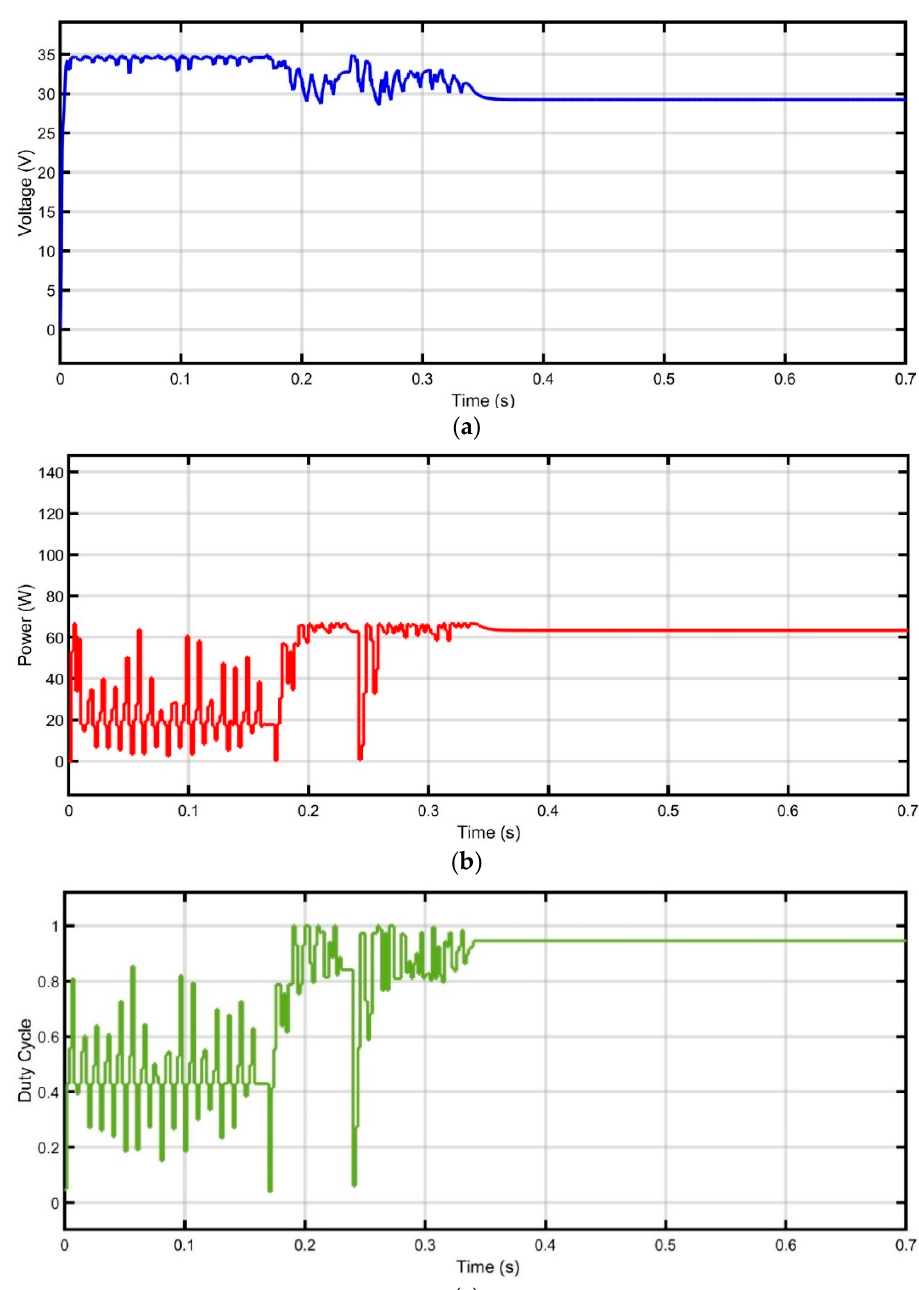
(c) the duty cycle using the incremental conductance method. Figure 15 shows the power consumption, voltage, and duty cycle using the cuckoo search method. Figure 16 shows the SCADA graphical user interface, (a) the voltage, (b) the power, and (c) the duty cycle using the cuckoo search method. Figure 17 shows the power consumption, voltage, and duty cycle using the IABC method. Figure 18 shows the SCADA graphical user interface, (a) the voltage, (b) the power, and (c) the duty cycle using the IABC method.